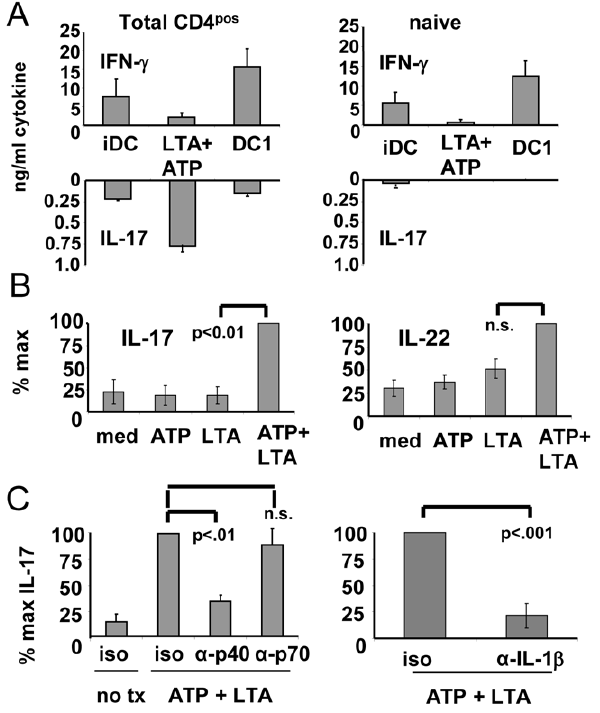
Figure 4. LTA and ATP act synergistically to promote IL-23 and IL-1 b dependent Th17-activation. Overnight cultures of monocytes were treated with ATP (100 uM) for 4–6 hrs followed by application of 10 ug/ml LTA. Other groups received either no treatment (iDC) or a standard DC1 polarizing regimen (see Materials and Methods). Cells were harvested 5–6 h after TLR ligand application to serve as stimulators. (A) Monocytes were co-cultured with purified CD4 pos (naı¨ve + memory) or CD4 pos /CD45RO neg (naı¨ve) T cells at 1:10 stimula- tor:responder ratios. After 6 days co-culture, T cells were harvested and re-cultured on tissue culture plates pre-coated with anti-CD3 and anti- CD28 antibodies, with supernatants harvested 24 h later and analyzed by ELISA for IFN- c and IL-17. Results shown from 6 allogeneic APC:T cell pairings + / 2 SEM. (B) Culture supernatants removed from initial co- cultures of total CD4 pos populations on day 5 (prior to cell harvest and APC:T cell pairings + / 2 SEM. (C) Co-cultures of APCs and total CD4 pos T cells were initiated in the presence of IL-23/12 (p40), IL-12 (p70) or IL1 b –neutralizing MoAb, or isotype controls, with culture supernatants harvested on day 5 and analyzed for IL-17 production by ELISA Results from 3 allogeneic APC:T cell pairings + / 2 SEM.